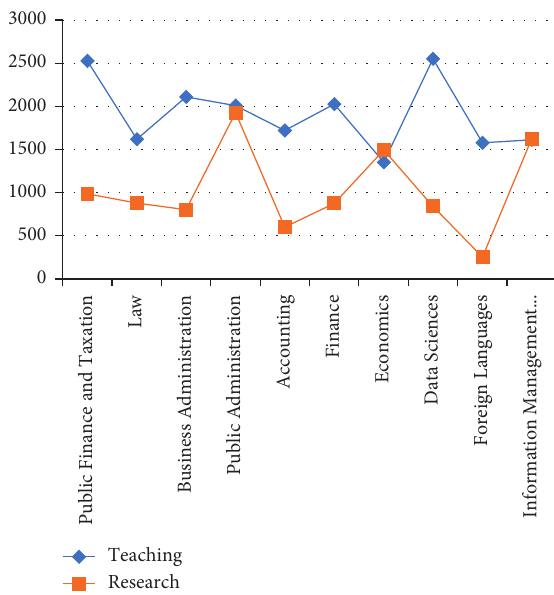
Figure 1: Average workload of every college in Z University.